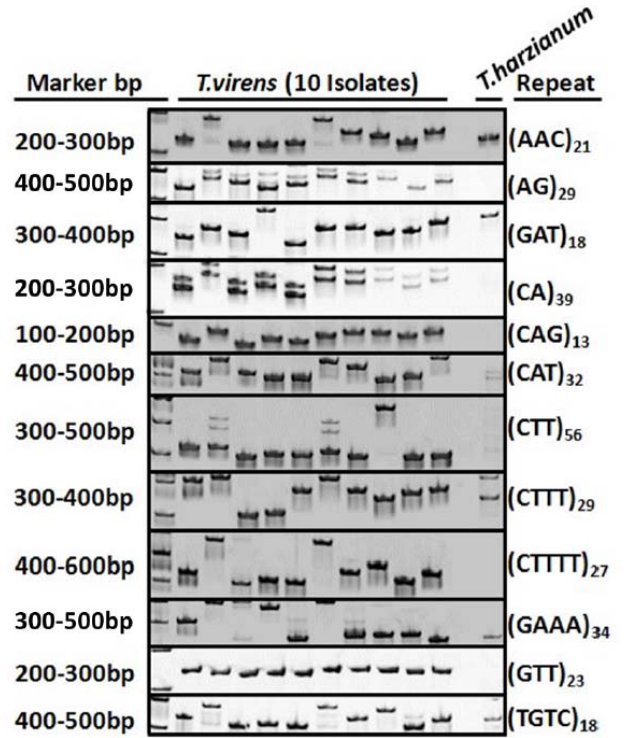
Figure 1. Fragment analysis at 12 microsatellite loci of T. virens examined on 5% PAA gels. Sample order from left to right: 100 bp DNA length standard, 10 T. virens isolates (Italy, Australia, Iran, Papua New Guinea, Ivory Coast, USA, Germany, The Netherlands, Guadeloupe, and Moldova), blank lane, T. harzianum isolate